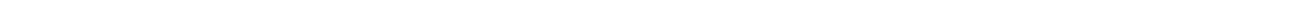
Fig. 2 Deletion of MCS-R2 using CRISPR/Cas9 genome editing in human CD34+ cells. a Schematic of sgRNA target sites. Four sgRNAs (Cr1, Cr2, Cr9, and Cr10) were designed to target the 5 ′ end of the MCS-R2 core element, whereas three sgRNAs (Cr7, Cr8, and Cr12) target the 3 ′ end. b Representative fl ow cytometry plots showing GFP expression and forward scatter (FS) after gating for live cells in non-transfection control (NTC), Cas9 control (C9), and CRISPR/Cas9 plasmid pair-transfected cells. Orange : GFP negative, blue : GFP positive (low), and green : GFP positive (high). Mean and SD of the percentage of cells within each region is indicated ( n = 3). Gating strategy is shown in Supplementary Fig. 10a. c Representative gel electrophoresis image of genomic DNA extracted from cells targeted by four CRISPR/Cas9 plasmid pairs analyzed by PCR. d Gene editing deletion induction ef fi ciency as measured independently by percentages of mutated alleles determined by band size in end-point PCR and subsequent Sanger sequence analysis and by determining inverse of proportions of amplicons inside: outside deletion (amplicons of same length) by multiplexed droplet digital PCR; mean values are presented and error bars represent SD ( n = 3). e Characterization of deletion break points by sequencing (co-ordinates from Hum Mar 2006 (NCBI36/hg18) assembly). f α -and β -globin gene expression normalized to the expression of RPL13A and α / β -globin mRNA ratios relative to Cas9 control (C9) analyzed by qPCR; error bars represent SD ( n = 3); * P < 0.05 and ** P < 0.01 relative to C9 (Student ’ s t -test). C9 Cas9-only